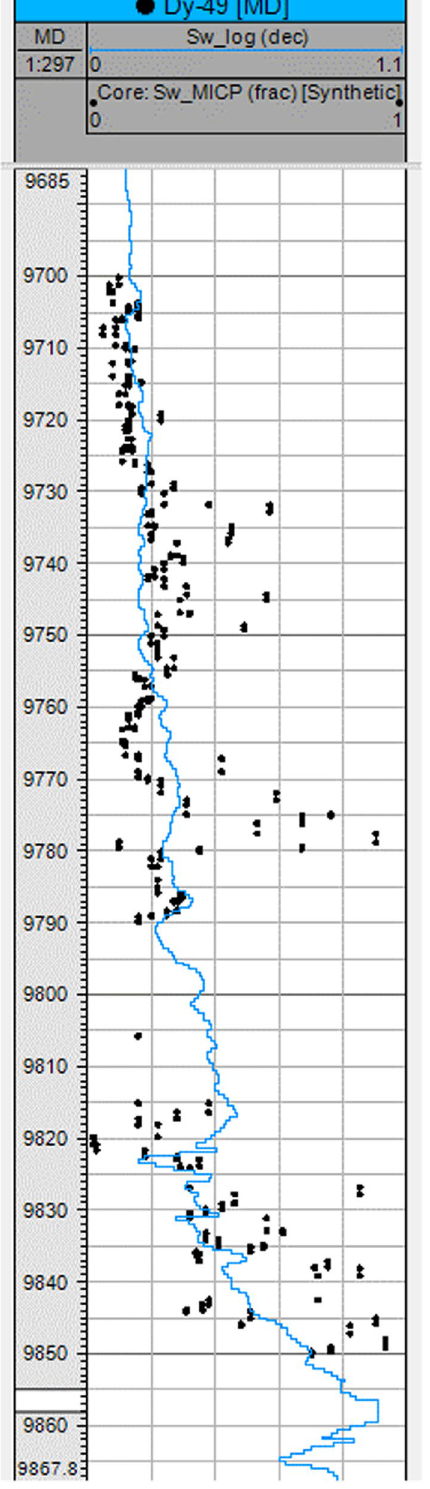
Fig. 6 Water saturation derived from MICP data (black-dotted) using buoyancy model and log-based water saturation (blue line)